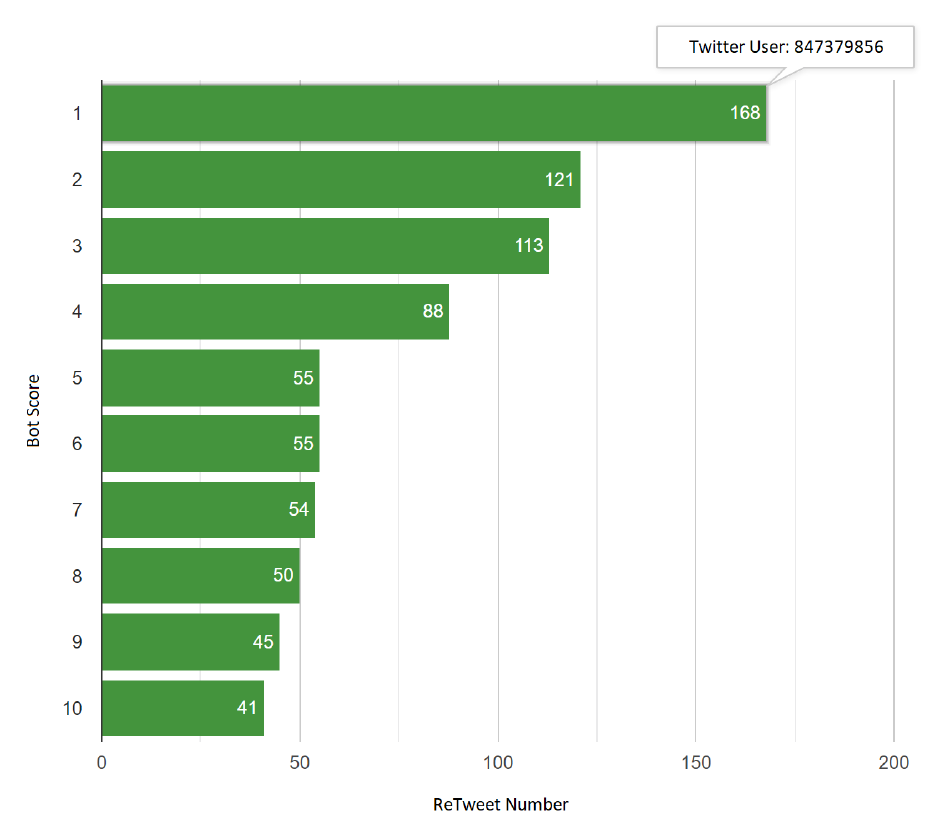
Figure 10. The top 10 Twitter users that may be